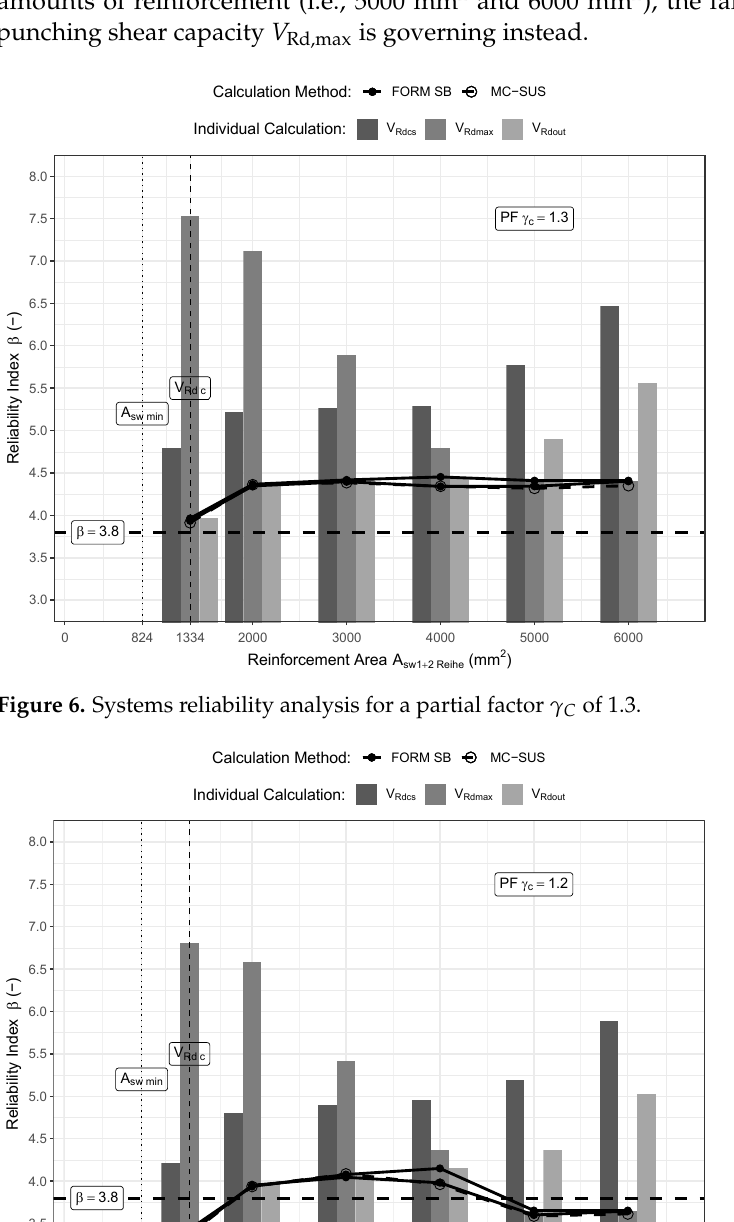
Figure 7. Systems reliability analysis for a partial factor 𝛾 (cid:3004) of 1.2.